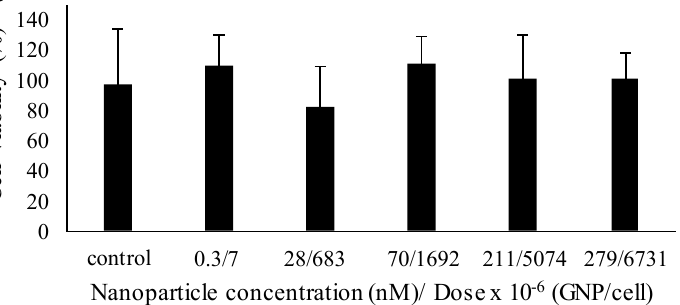
Figure 3. Evaluation of the GNP cytotoxicity. ( a ) GNP 800; ( b ) GNP 2000; ( c ) GNP 6000. hCECs were grown as monolayers (10 000 cells seeded per tissue-culture well, 2 wells per conditions) and exposed to increased doses of GNP. GNP were incubated with hCECs for 18 h, and the MTS added after media removal. Cell viability was obtained 4h after its addition by measuring the absorbance of formazan at 490 nm.